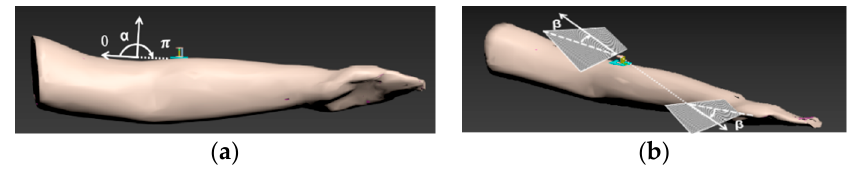
Figure 11. The on-arm measurement sketches: ( a ) E plane and ( b ) H plane.